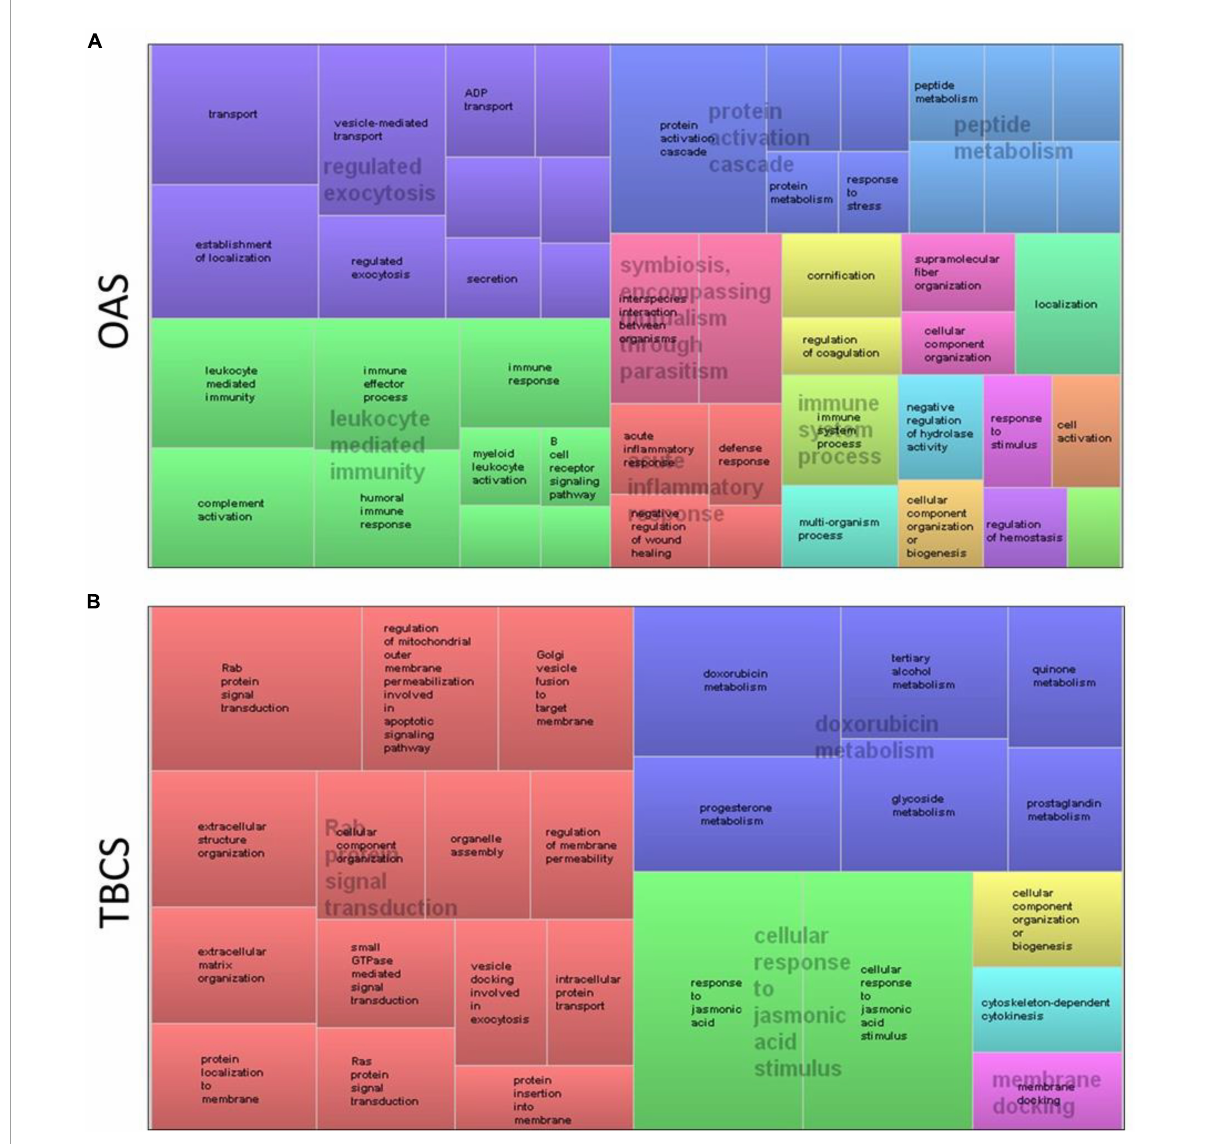
FIGURE3 Treemap visualization of the enriched biological process obtained from REVIGO analysis of differential proteins. (A) OAS and (B) TBCS. The most enriched physiological processes corresponded with larger components on the